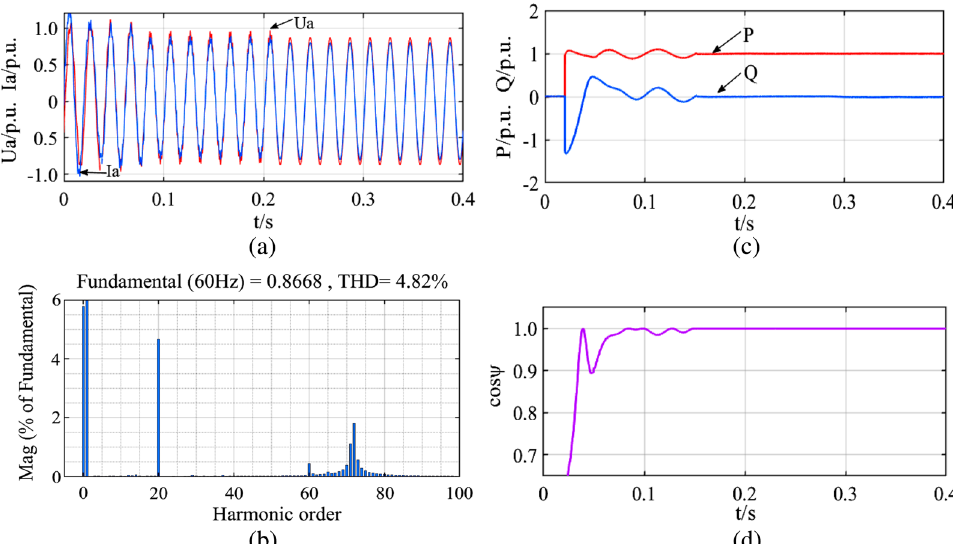
Fig. 14 A-phase waveforms of inverter with traditional feedforward decoupling PI control under initial condition a A-phase voltage and current at PCC, b harmonic analysis of A-phase grid current, c active and reactive power into power grid, d power